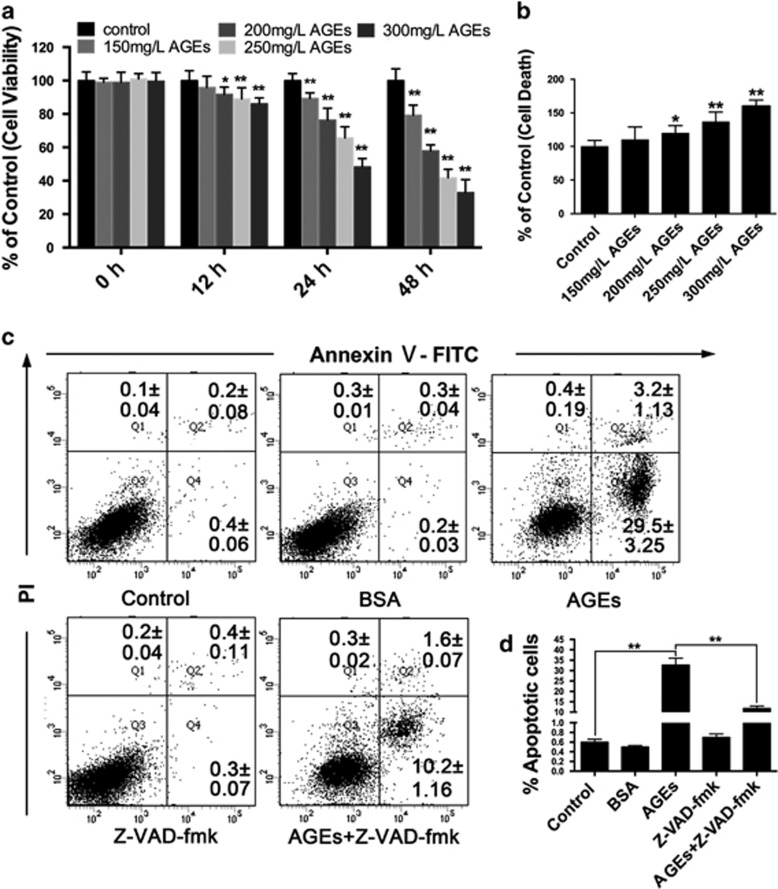
AGEs induced apoptosis in mesangial cells. (a) Cells were treated with various concentrations of AGEs (150–300 mg/l) for 0, 12, 24 or 48 h, and cell viability was estimated using the MTT assay. The data are presented as the mean±S.E.M. from at least three independent experiments. *P<0.05 versus Control, **P<0.01 versus Control. (b) Cells were treated with various concentrations of AGEs (150–300 mg/l) for 24 h. Cell death was estimated using a cell death detection ELISAPLUS assay. The data are presented as the mean±S.E.M. from at least three independent experiments. *P<0.05 versus Control, **P<0.01 versus Control. (c) Cells were pre-treated with or without Z-VAD-fmk (25 μM) and incubated with AGEs (250 mg/l) for 24 h. Cell apoptosis was detected using the annexin V-FITC/PI kit. Viable cells (annexin V−/PI−), early apoptotic cells (annexin V+/PI−), late apoptotic cells and necrotic cells (annexin V+/PI+) are located in the bottom left, bottom right and top right quadrants, respectively. The numbers in each quadrant represent the percentage of cells. The data are presented as the mean±S.E.M. from at least three independent experiments. (d) Percentages of apoptotic cells in each group. The data are presented as the mean±S.E.M. from at least three independent experiments. **P<0.01